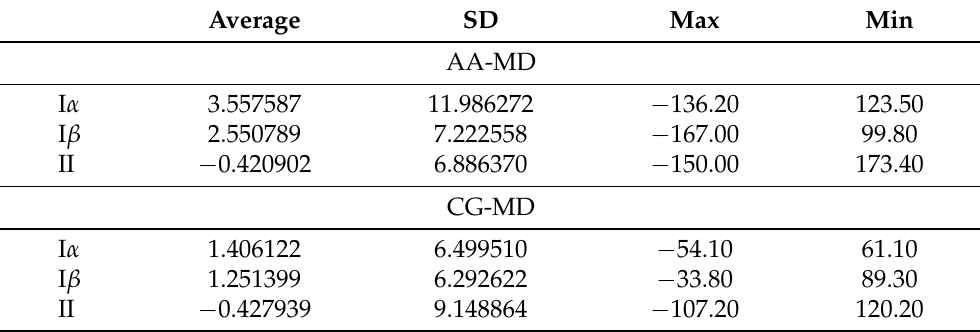
Table 5. Statistics of twist angles for all cellulose fibrils. The error in the measurements corresponds to the standard deviation (SD) for each